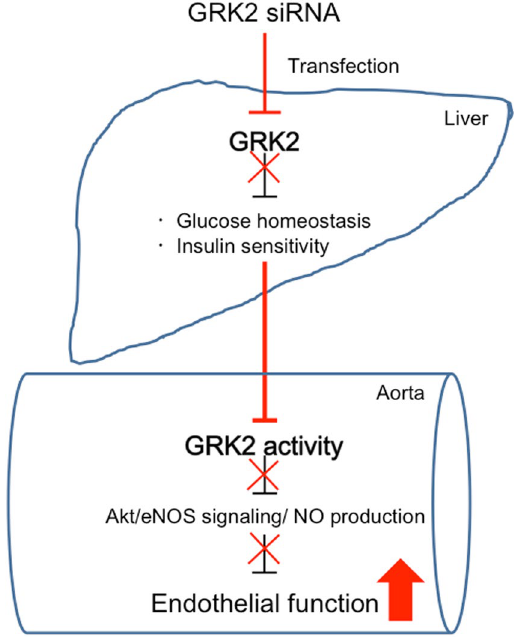
Figure 9. A model for interaction between liver and aorta based on GRK2 siRNA transfection in T2DM models. Hepatic GRK2 inhibition normalized the Akt/eNOS-dependent vascular response via improving glucose homeostasis in T2DM. Glucose homeostasis could constitute a network for replication between liver and